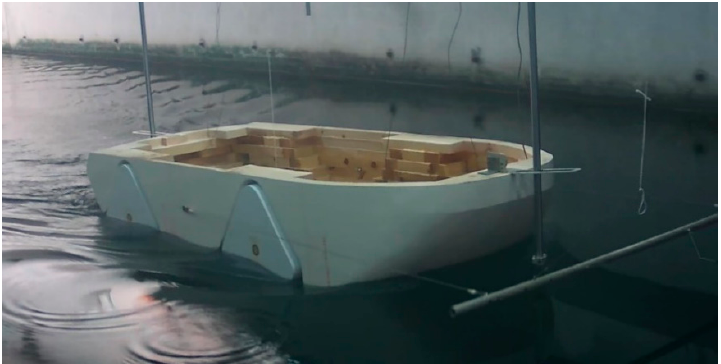
Figure 8. Picture of towing test. Table 4. Parameters of towing test instruments.